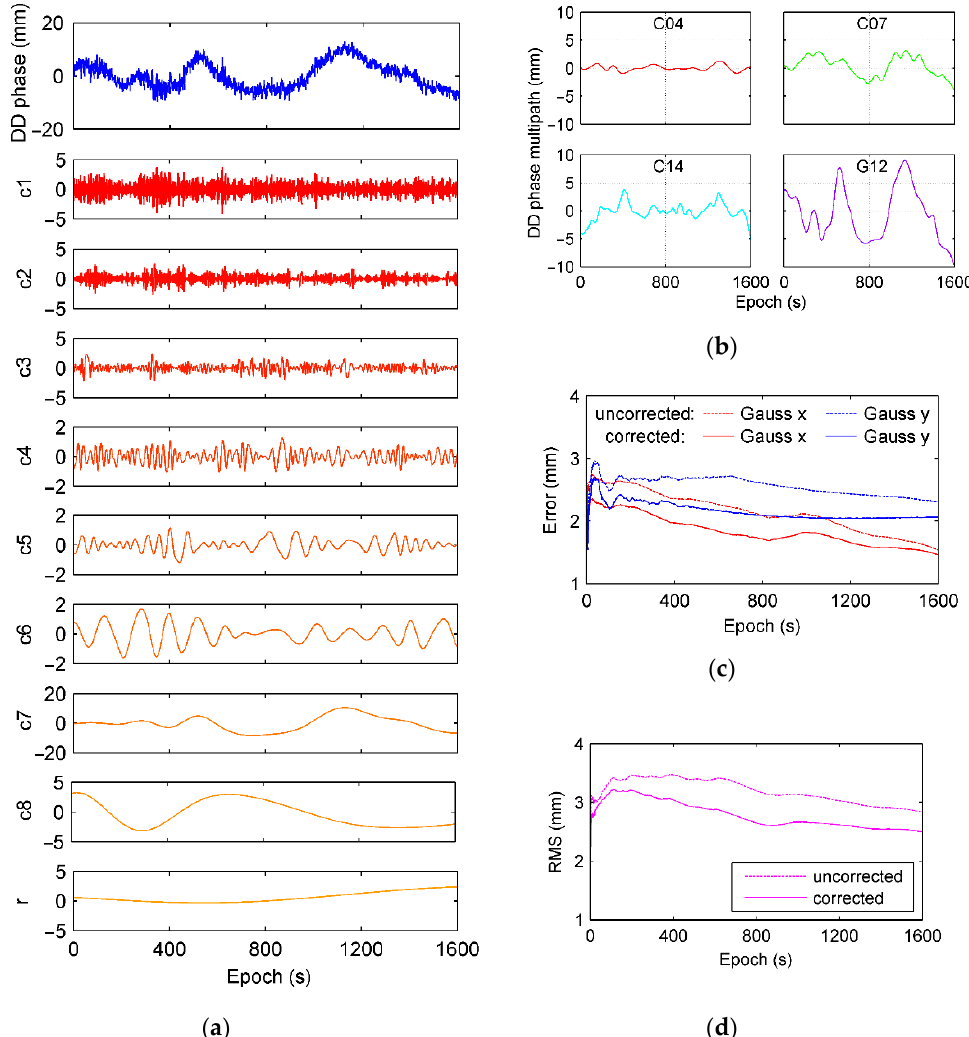
Figure 24. ( a ) Decomposed layers for double differential carrier phase of satellite G12 using EMD approach, ( b ) is multipath of double differential carrier phase extracted by HHT, ( c ) is the root-mean-square error of precise relative positioning, and ( d ) is the distribution of the root mean